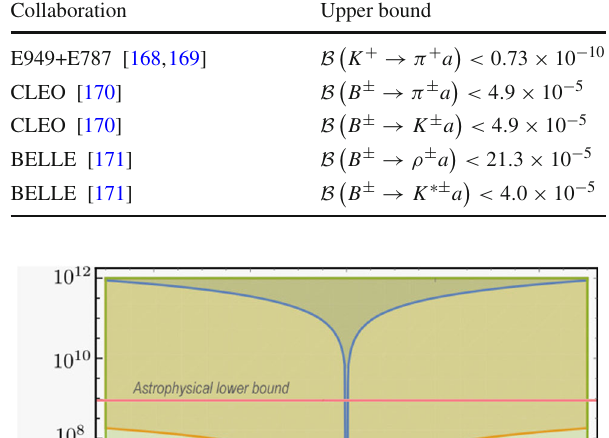
stands for K ± , B ± and m = π ± , K ± , K ∗ , ρ . These